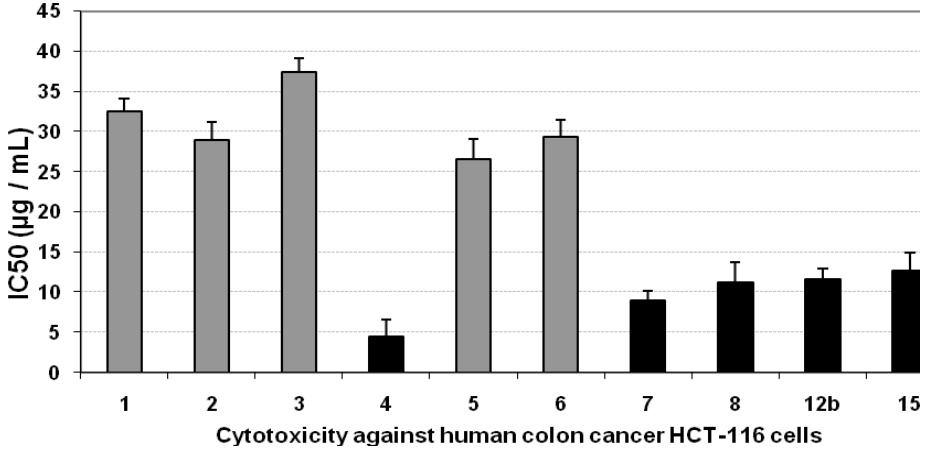
Figure 3. Cytotoxicity (IC50, µg/mL) of different tested compounds against human HCT-116 cells 48 hours of incubation. The grey bars represent non-cytotoxic compounds, and the black bars represent the promising cytotoxic compounds. Data are representing mean value of IC50 ±